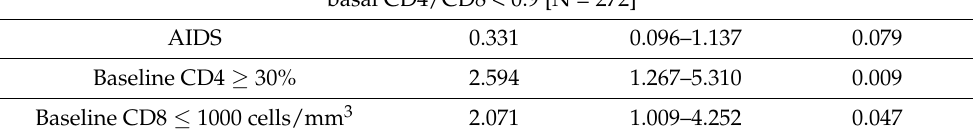
basal CD4/CD8 < 0.9 [N =